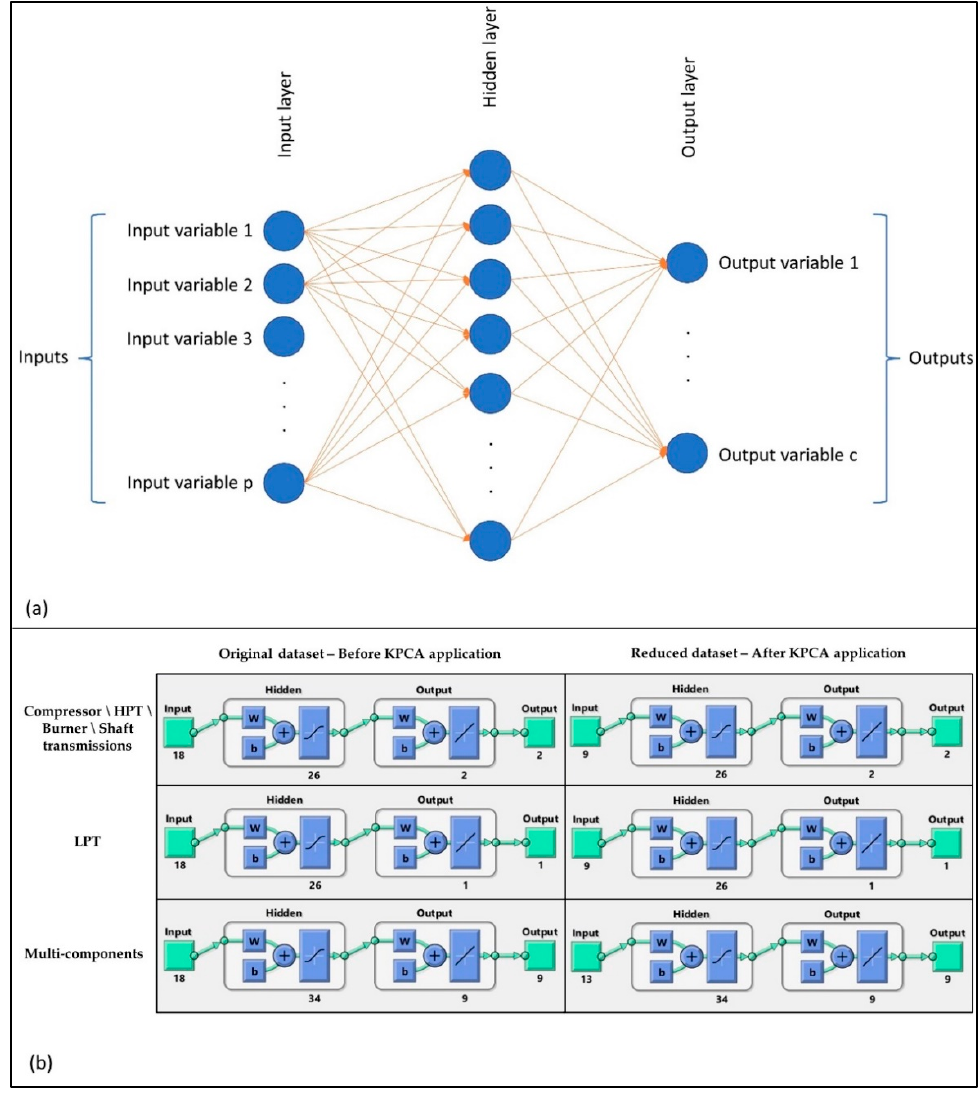
Figure 2. A typical structure of an FFNN ( a ) and neural networks used in this work ( b ), whose structure is based on the one represented in the top.